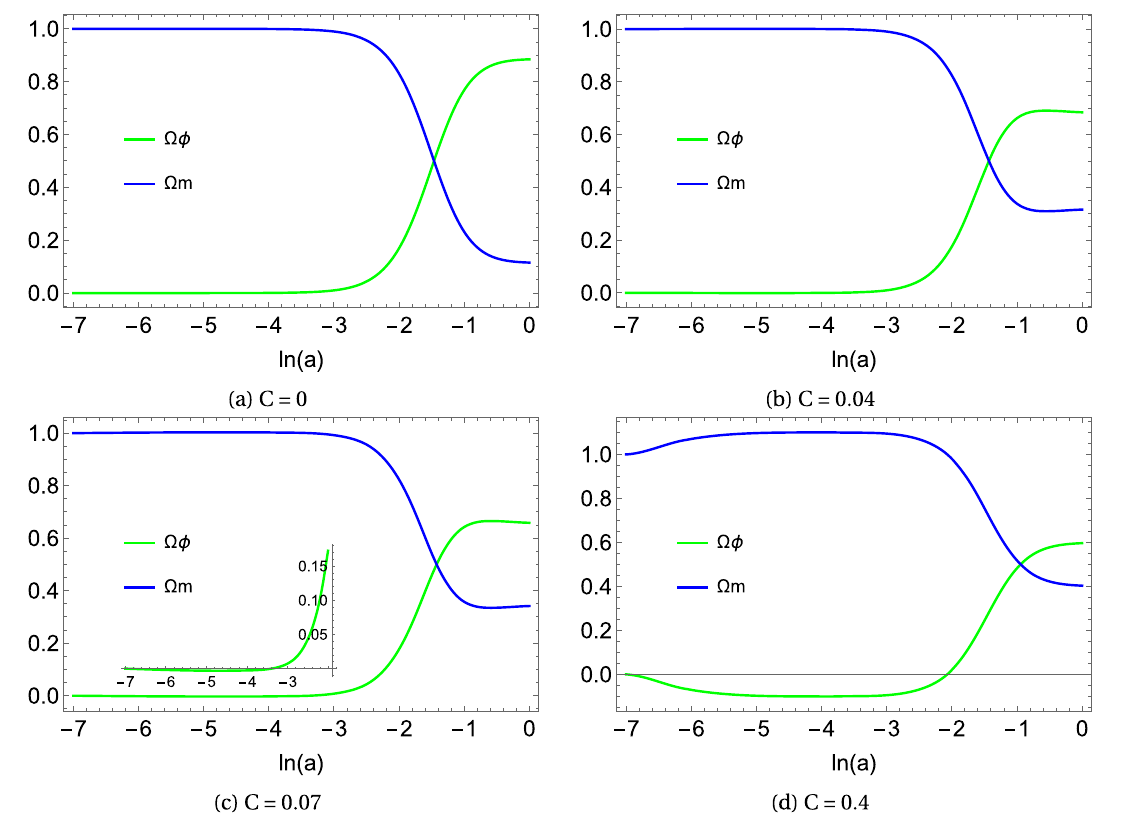
Fig. 4 The relative density parameter of DE ( (cid:12) φ ) and DM ( (cid:12) m ) with varying N = ln(a) for various values of coupling constant (C)